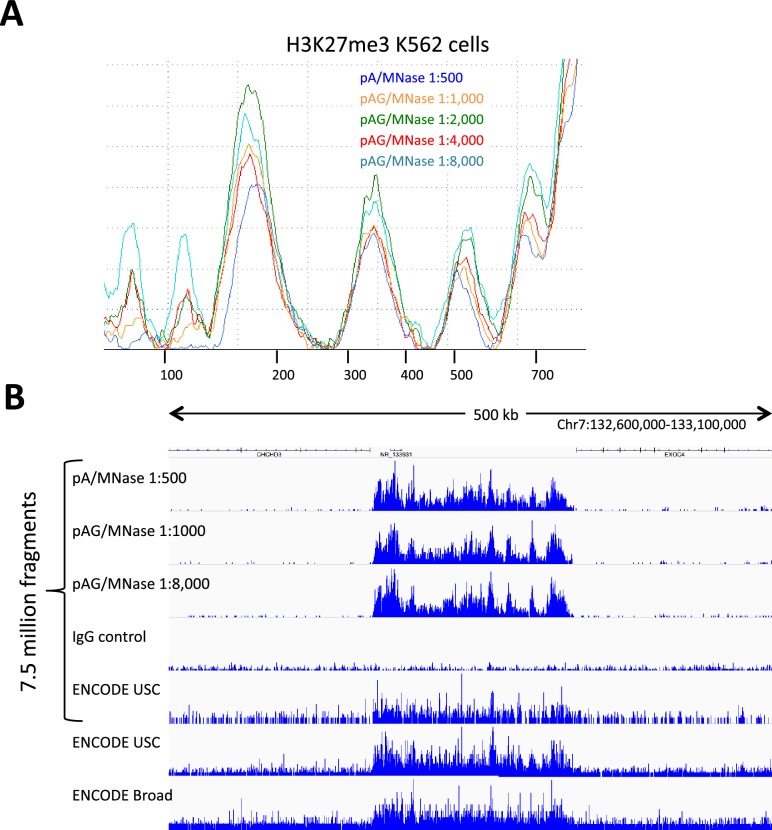
pAG/MNase titration.(A) K562 cells were incubated with an antibody to H3K27me3 (CST #9733 Rabbit monoclonal), washed twice with 1 ml Dig-wash. The sample was split into aliquots for incubation with pA/MNase at the recommended concentration and a serial dilution of pAG/MNase, followed by 3 1 ml washes. After 30 min using the standard protocol, lImit digestions are seen at all dilutions for this abundant epitope, indicating that the amount of fusion protein used in this experiment was in excess. (B) Representative tracks from these samples on the same normalized count scale show consistently low CUT&RUN backgrounds with excess pAG/MNase, which indicates that washes are sufficient to minimize non-specific background cleavages. ENCODE ChIP-seq tracks are shown for comparison, where USC used CST #9733, and Broad Institute used Millipore 07–449.